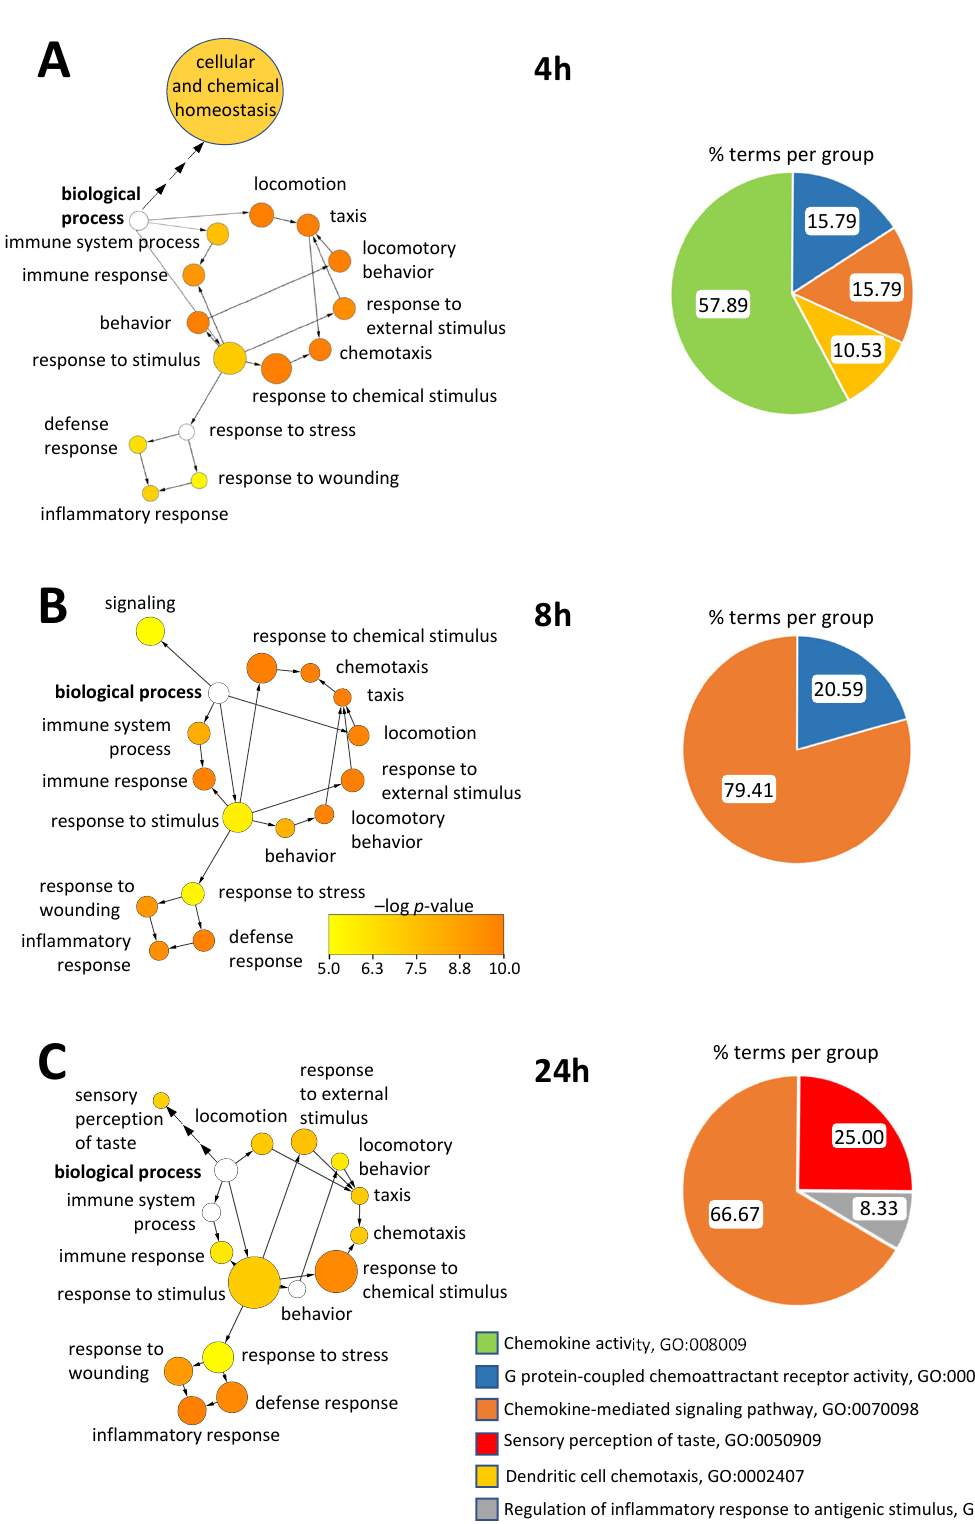
Figure 7. Gene ontology term network analysis of sweetener intervention-regulated VIP-genes. (( A – C ), left panels), functional networks from a BiNGO analysis visualize the VIP-gene sets (Figure 6, Table S7) associated with their significantly overrepresented GO terms at the respective post- intervention times. (( A – C ), right panels), pie-charts from a ClueGO GO term cluster analysis display the percentage of the number of subcategory ontology terms associated with the VIP-genes (Figure 6, Table S7) at the respective post-intervention